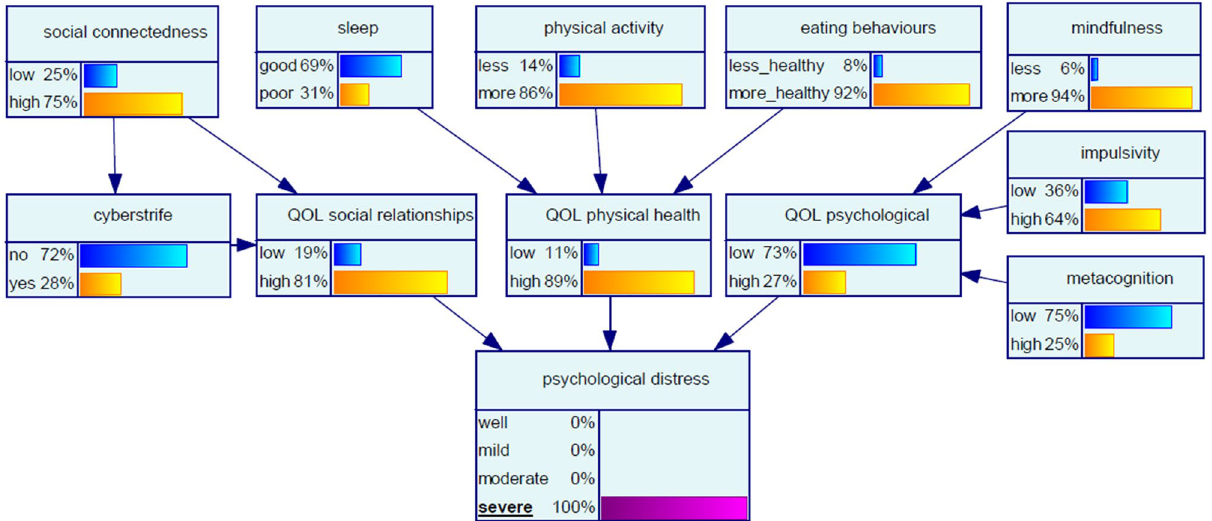
Figure 3. Bayesian network for Scenario 2 ‘certainty for severe psychological